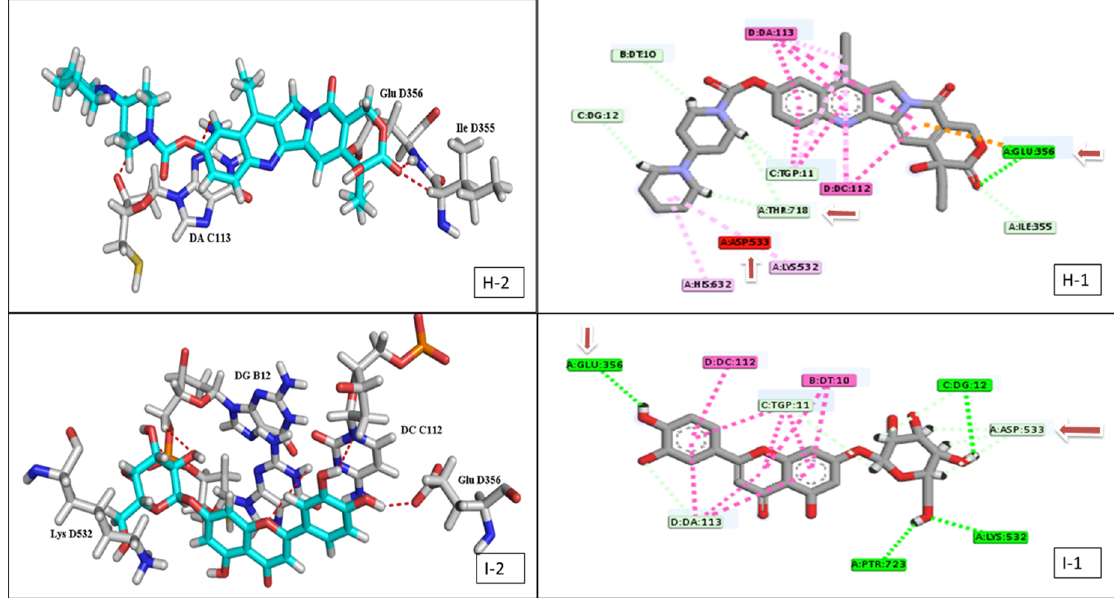
Figure 6. 2D & 3D interaction of the top docking pose of irinotecan ( H-1 , H-2 ) and compound 16 ( I- 1 , I-2 ) at the active site of topoisomerase-1 enzyme.